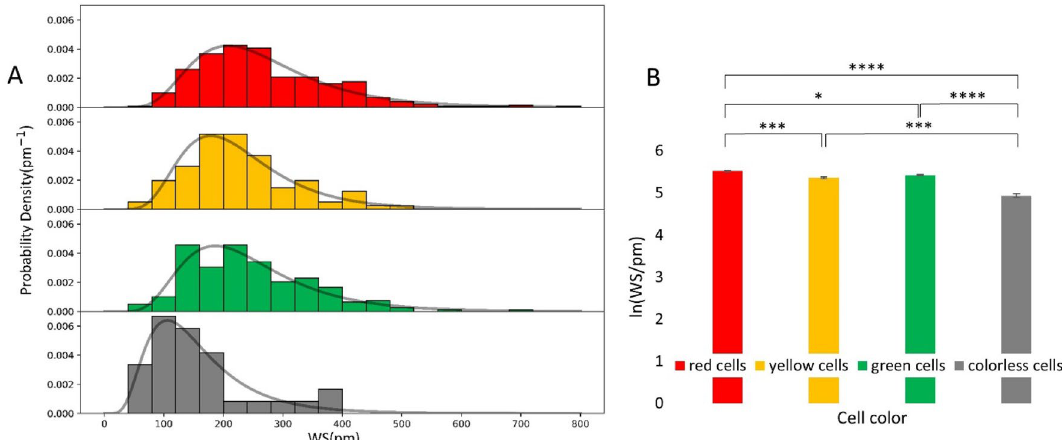
Figure 5. Biosensor data of the recorded single-cell signals at a single pixel underneath of each cell. ( A ) The local biosensor signals of individual cells (maximal WS pixel value corresponding to a given cell) followed a lognormal distribution (solid line) in all cell-cycle states. ( B ) Normalized data showed significant differences between the various phases in a decreasing order of red, green, and yellow cells, with a distinctly less signal for the colorless cells. Mean ± SEM is shown. (n = 325 red cells, n = 197 green cells, n = 30 colorless cells, and n = 102 yellow